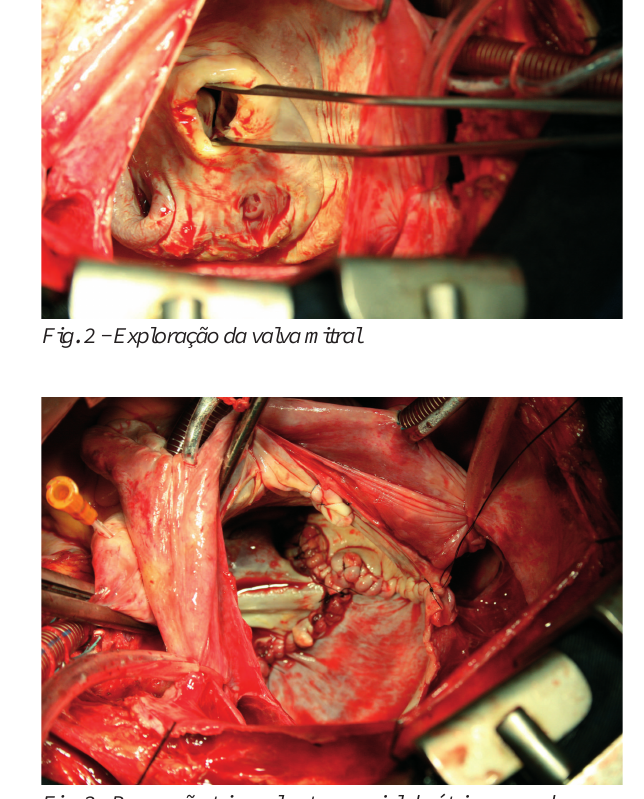
Fig. 1 - Atriotomia esquerda exibindo o aumento da